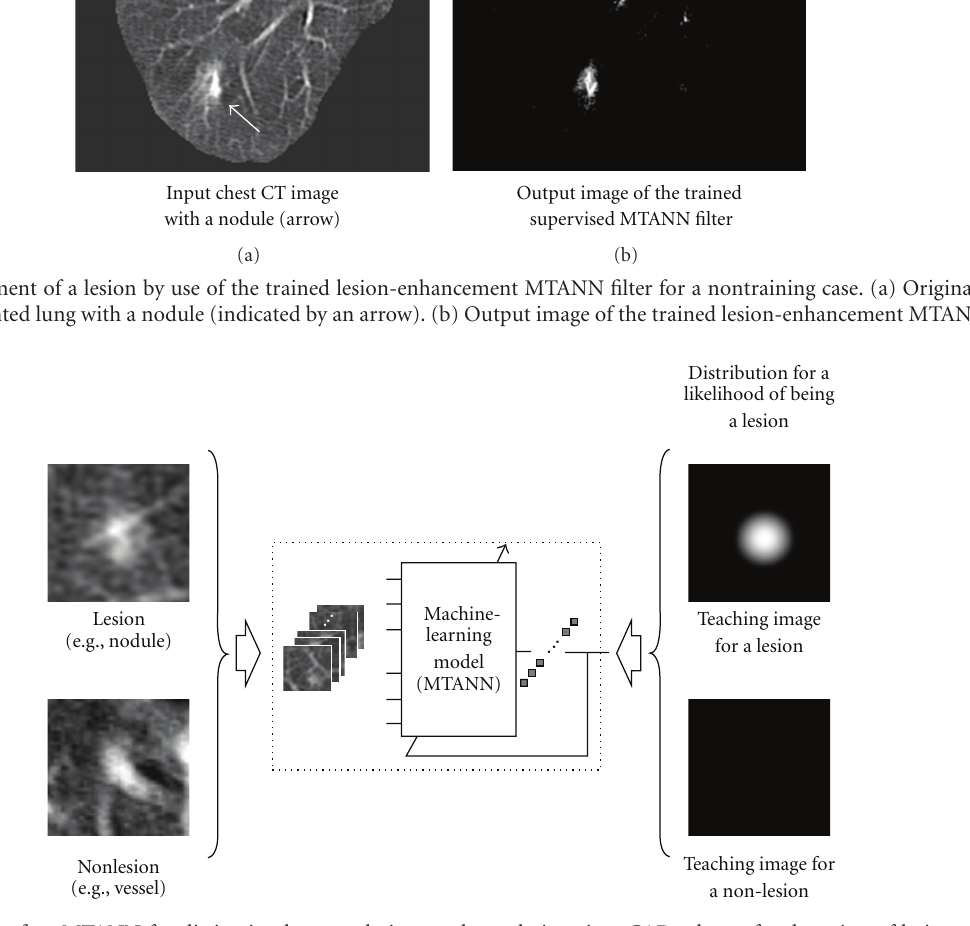
Figure 10: Training of an MTANN for distinction between lesions and non-lesions in a CAD scheme for detection of lesions in medical images. The teaching image for a lesion contains a Gaussian distribution; that for a non-lesion contains zero (completely dark). After the training, the MTANN expects to enhance lesions and suppress